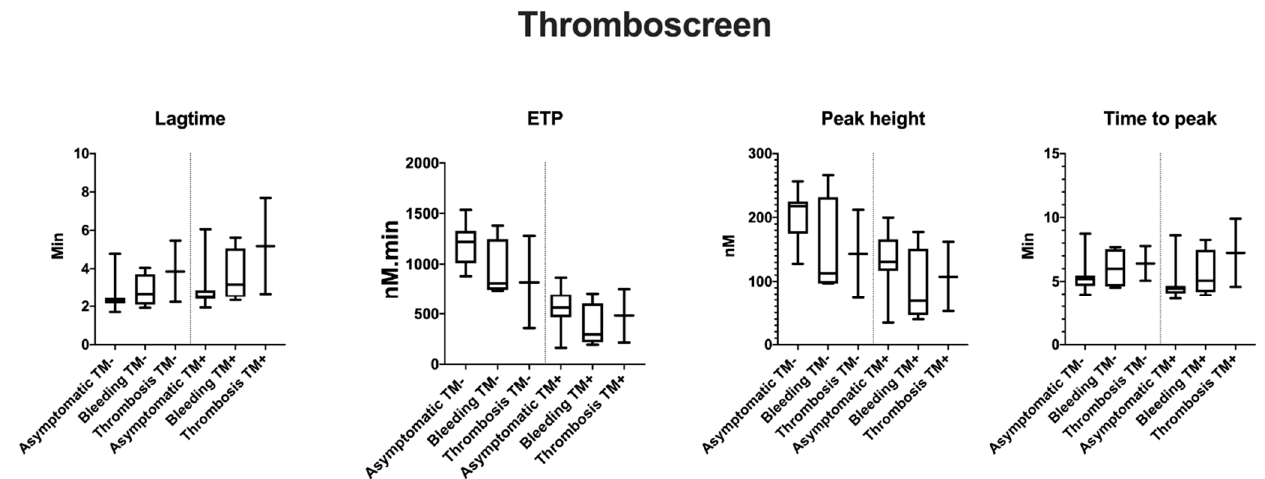
Figure 2. Mean TG variables with STG-TS (thromboscreen) according to clinical phenotype and the supplementation of TM. TG values are shown for 19 patients as follows: asymptomatic n = 13; bleeding n = 4, thrombosis n = 2; hypofibrinogenemia n = 8; dysfibrinogenemia n = 8; and hypodysfibrinogenemia n = 3.